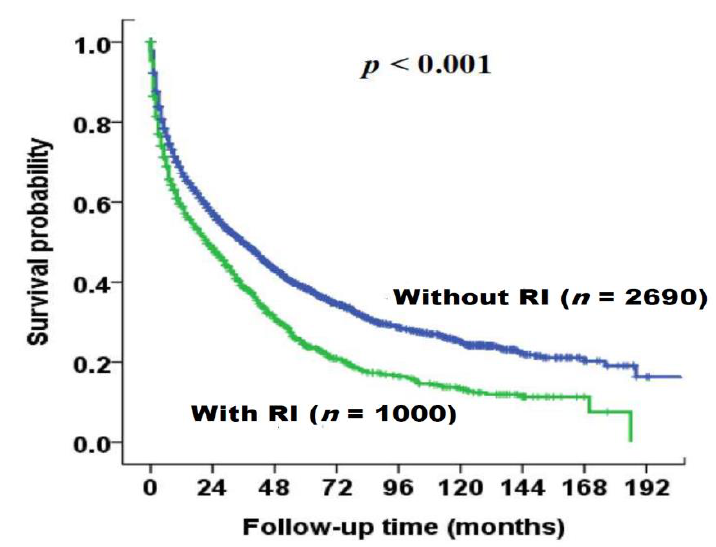
Figure 2. Survival distribution of the entire HCC cohort ( n = 3690), stratified by renal insu ffi ciency (RI, eGFR < 60 mL / min / 1.73 m 2 ) using the Kaplan–Meier method with log-rank test. Patients with renal insu ffi ciency had significantly decreased long-term survival compared to those without renal insu ffi ciency ( p < 0.001).